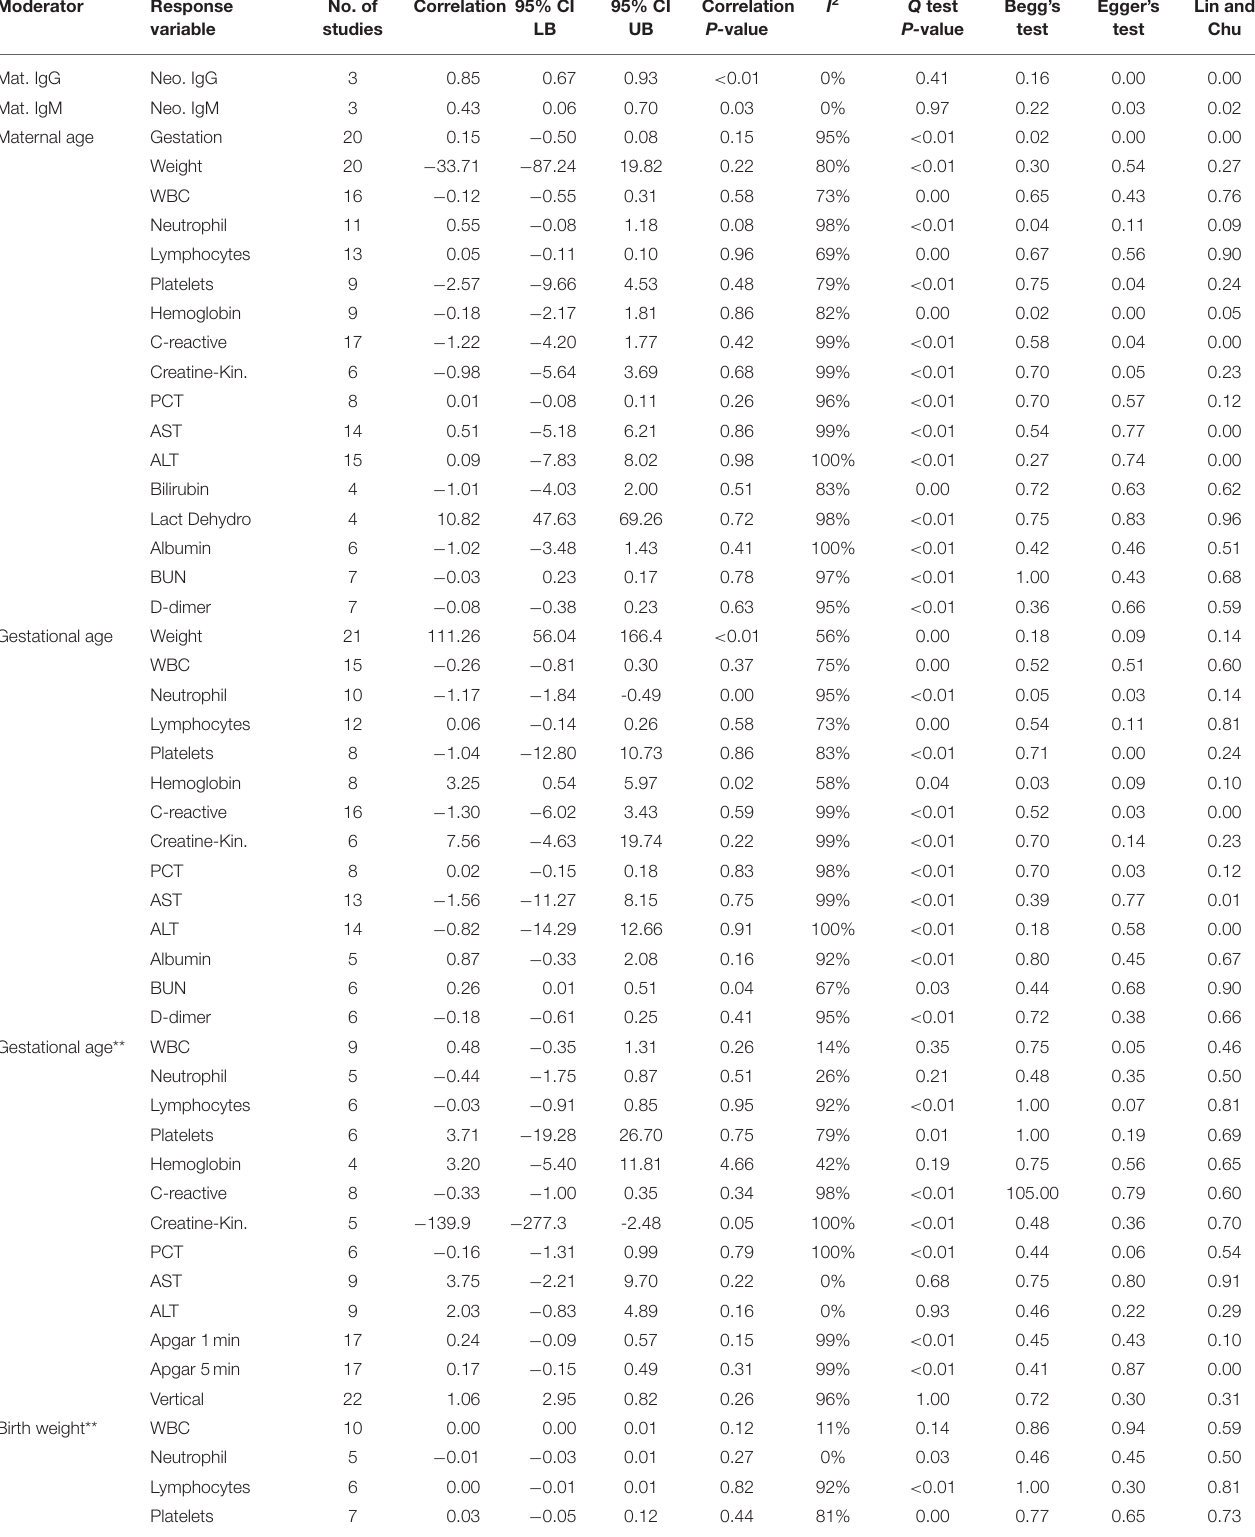
TABLE 3 | Meta-analysis of correlations between maternal and neonatal characteristics.